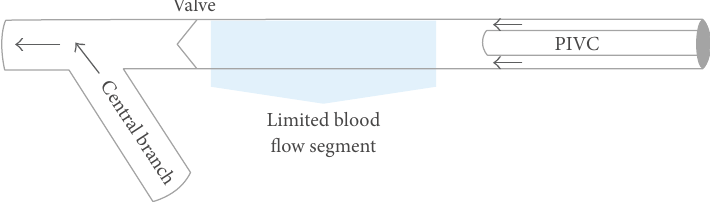
Figure 5: Diagram of hypothetical limited flow segment created by the confluence of vein size, distant central branch, and valve between branch and